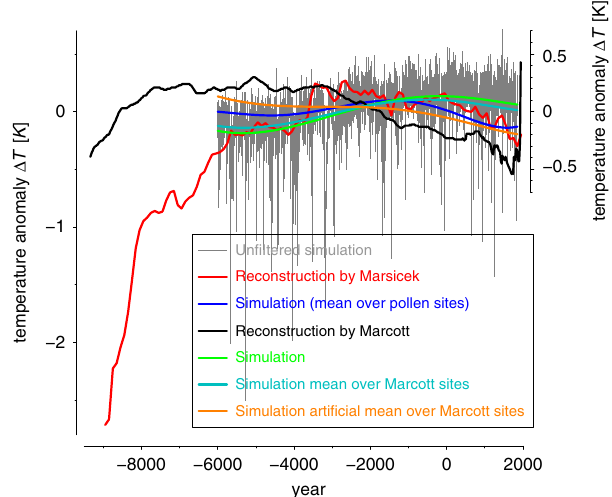
Fig. 1 Annual global-mean temperature anomaly during the Holocene based on reconstructions and a transient simulation. The annual global mean temperature anomaly based on the reconstructions by Marcott 3 (black curve), based on the reconstruction by Marsicek 4 (red curve), based on the transient un fi ltered simulation (gray curve), based on the low-pass fi ltered simulation (green curve), based on the low-pass fi ltered simulation over the pollen sites used for the Marsicek reconstruction (blue curve), based on the low-pass fi ltered simulation over the Marcott sites (cyan), and based on an arti fi cial simulation dataset over the Marcott sites (orange). All time series have been adjusted to the simulation time period (6000 BCE to 1850 CE). The units are Kelvin. The y-axis on the left side also shows the temperature anomaly but with a fi ner scale for easier comparison of the curves over the last millennia. For the computation for the arti fi cial simulation dataset please see text for